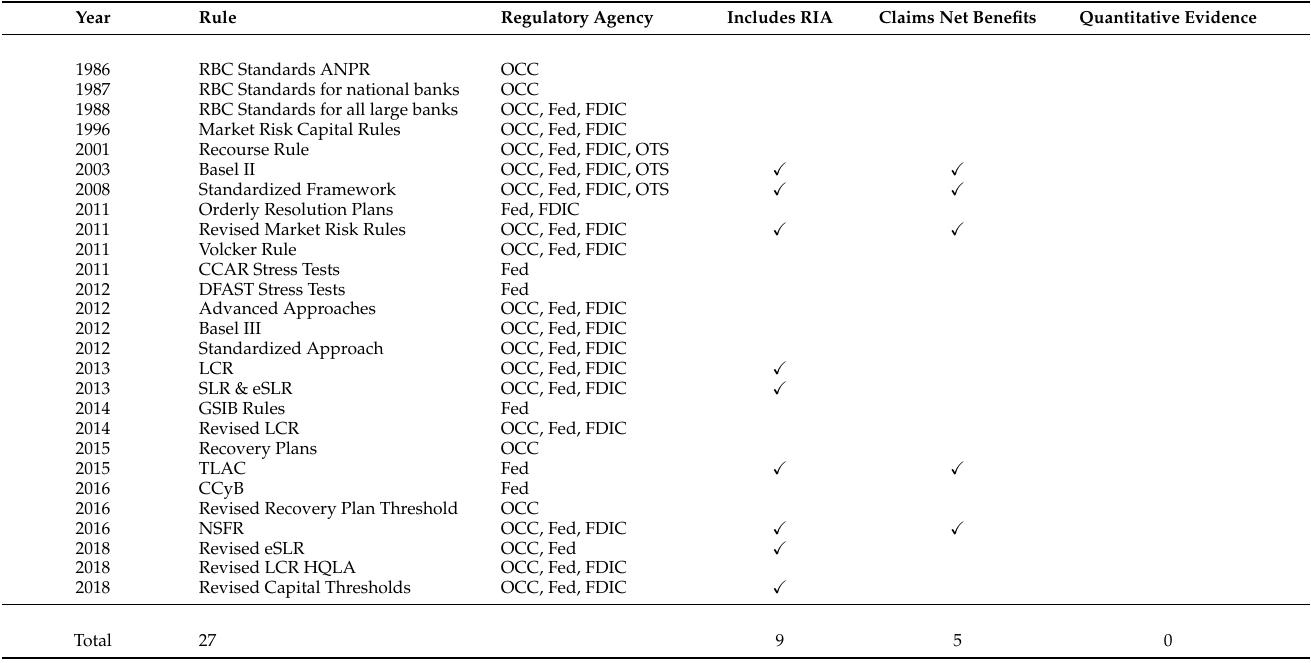
Table 2. Regulatory Impact Analysis (RIA) in capital and liquidity rule